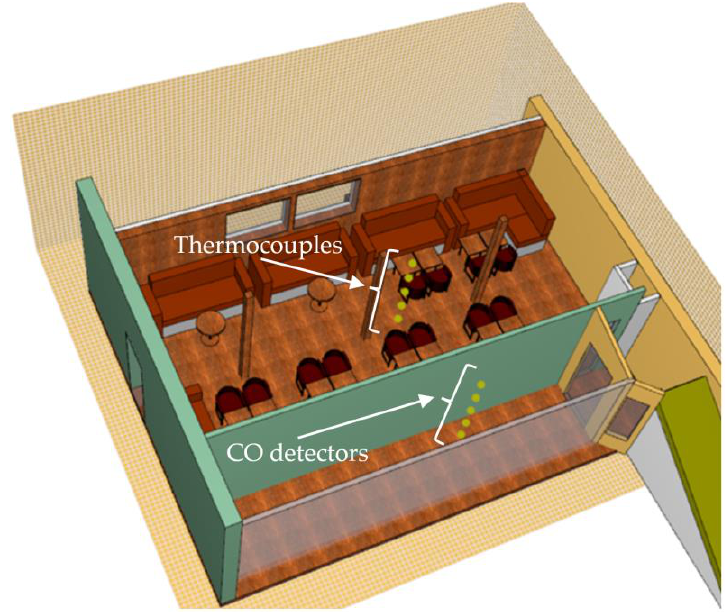
Figure 5. The virtual model of the geometry used for fire simulation (the 1st floor of the restaurant).